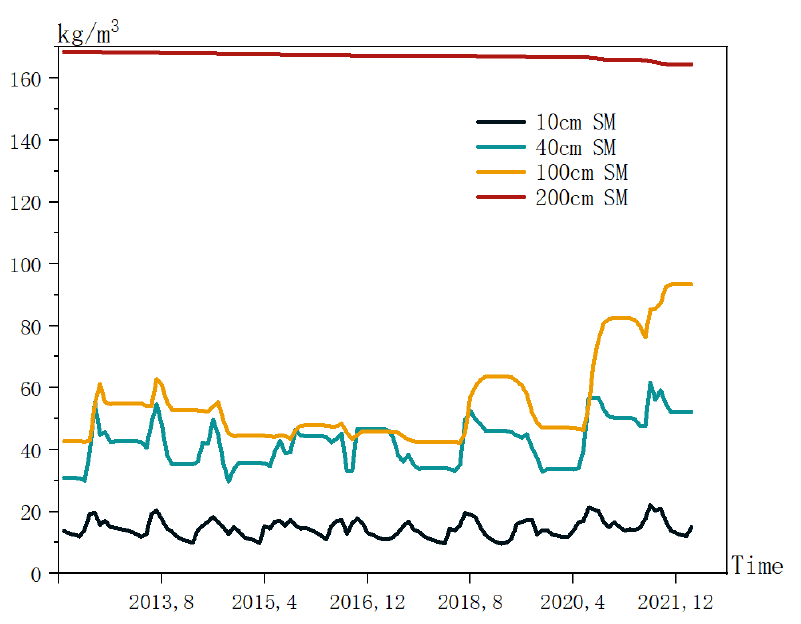
Figure 3. Line graph of the historical soil moisture data at different depths.